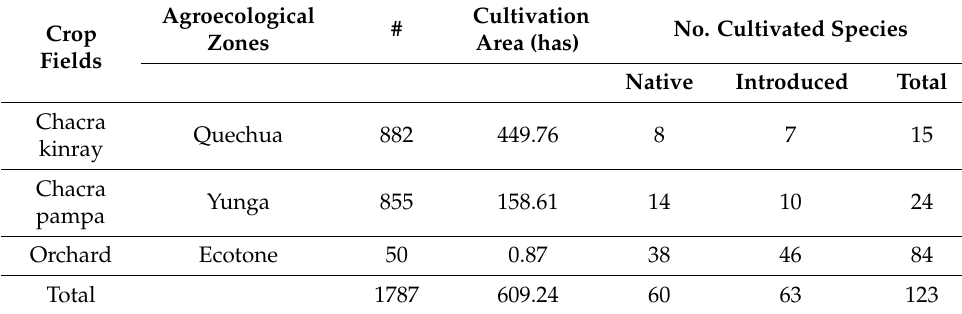
Table 5. Crop fields of the Nizag